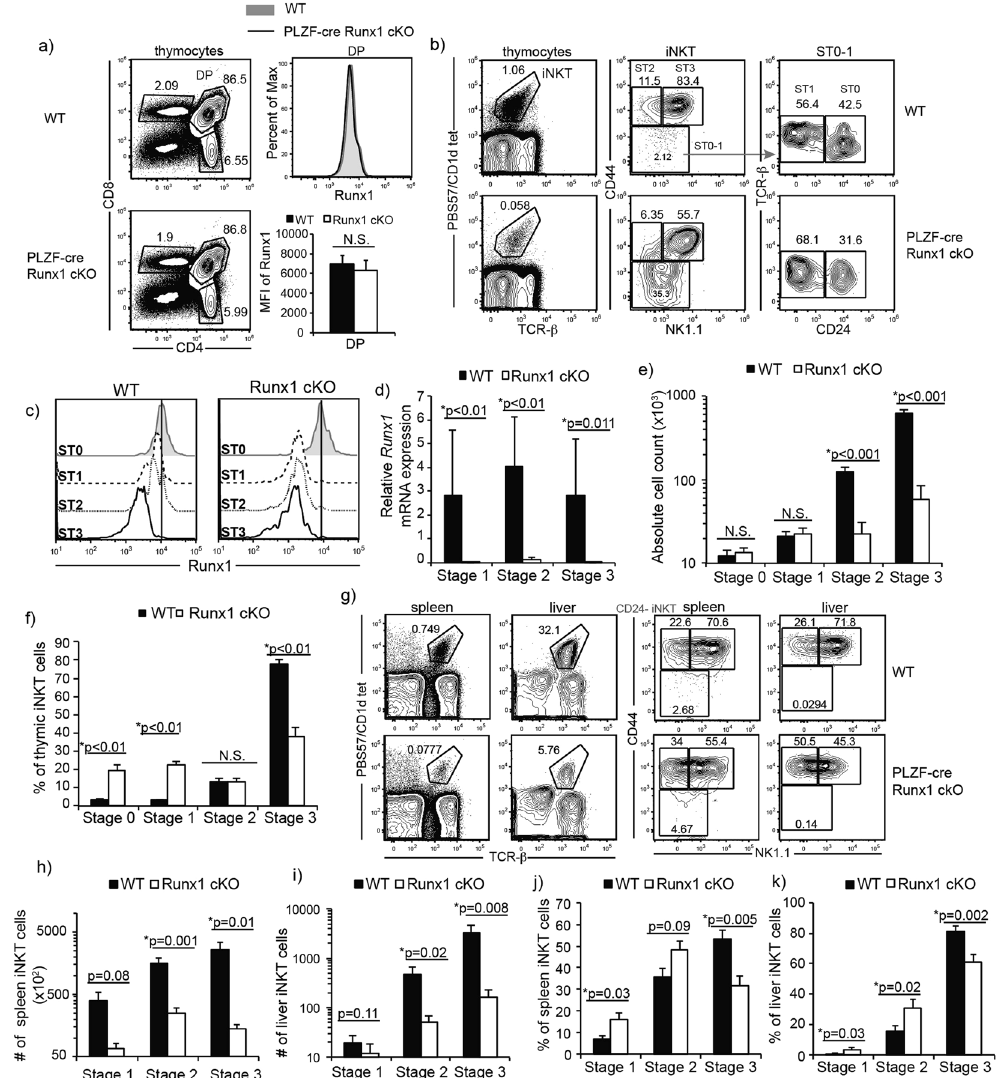
Figure 1. Runx1 is required for iNKT cell development. ( a ) Thymic CD4/CD8 profile in WT and PLZF-cre Runx1 cKO mice. Expression and quantification of Runx1 in DP thymocytes from WT (grey filled) and PLZF- cre Runx1 cKO (black line) mice. Data is representative and calculated from 11 mice per group. ( b ) Examination of thymic iNKT cells in their developmental stages in WT (top) and PLZF-cre Runx1 cKO mice (bottom). iNKT cells were identified using expression of TCR- β and CD1d/PBS57 loaded tetramers. Gated iNKT cells were further characterized into stages using NK1.1, CD44 and CD24 markers: Stage 0 (CD24 + CD44 − NK1.1 − ) Stage 1 (CD24 − CD44 + NK1.1 − ) Stage 2 (CD44 hi NK1.1 − ) and Stage 3 (CD44 + NK1.1 + ). Data is representative of at least 30 mice per genotype from at least 20 independent experiments. ( c ) Expression of Runx1 in Stage 0–3 iNKT cells from WT (grey filled) and PLZF-cre Runx1 cKO (black line) mice. Data is representative of at least 7 mice/genotype from 5 independent experiments. ( d ) Relative mRNA expression of Runx1 in sorted Stage 1–3 iNKT cells of WT (black bars) and PLZF-cre Runx1 cKO (white bars) mice. Data is normalized to expression of Runx1 in WT Stage 3 iNKT cells = 1. Data is calculated from 3 WT and 3 PLZF-cre Runx1 cKO mice from 3 independent sorts. ( e,f ) Absolute cell count and percent of thymic iNKT cells at Stage 1, 2 and 3 in WT (black bars) and PLZF-cre Runx1 cKO mice (white bars). Data is calculated from at least 30 mice per group in the age range of 5–12 weeks old. ( g ) Representative frequencies of iNKT cells in spleen and liver of WT and PLZF-cre Runx1 cKO mice. Data is representative of at least 12 mice/genotype from 8 independent experiments in spleen and 9 mice/genotype from 7 independent experiments in liver. ( h-i ) Total Stage 1–3 iNKT cell count from spleen and liver. ( j-k ) Frequency of Stage 1–3 iNKT cells in the spleen and liver. ( h-k ) Data is calculated from at least 12 mice per group from 8 independent experiments in spleen and 9 mice/genotype from 7 independent experiments in liver. All statistical analysis was done using Student’s t-test . Means ±